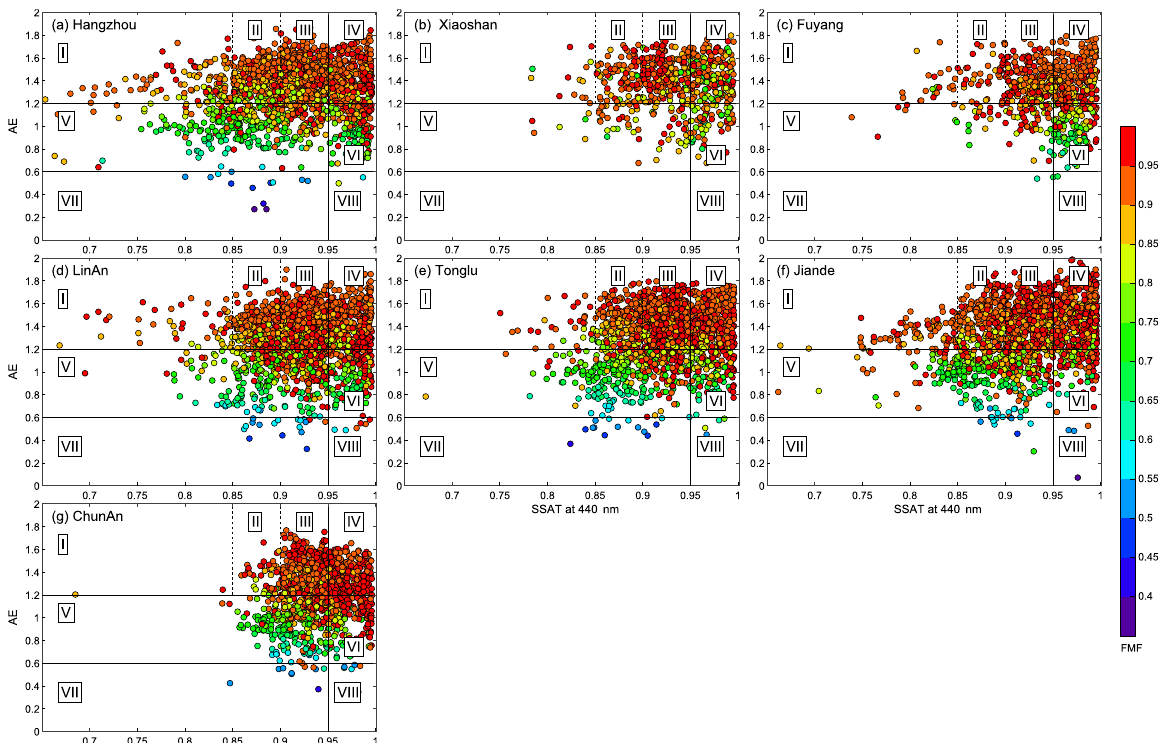
Figure 8. The aerosol type classification using SSA as a function of AE 440 − 870nm over (a) Hangzhou, (b) Xiaoshan, (c) Fuyang, (d) LinAn, (e) Tonglu, (f) Jiande and (g) ChunAn. See text for description of groups I–VII.